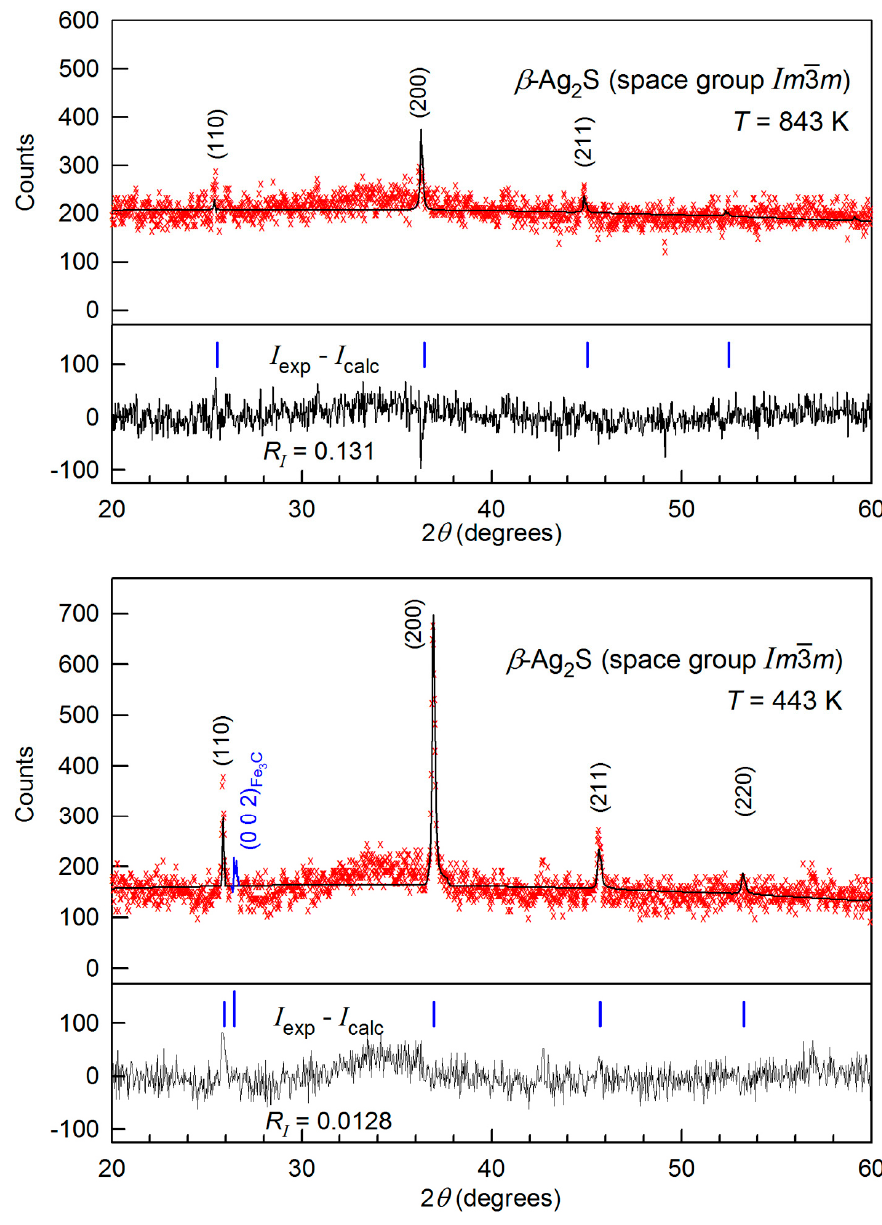
Figure 2. Experimental ( × ), calculated (—), and difference ( I exp — I calc ) XRD patterns of Ag 2 S pressed pill at temperatures of 443 and 843 K (According to the structure refinement, studied silver sulfide has bcc (space group Im 3 m ) structure of β -Ag 2 S argentite).